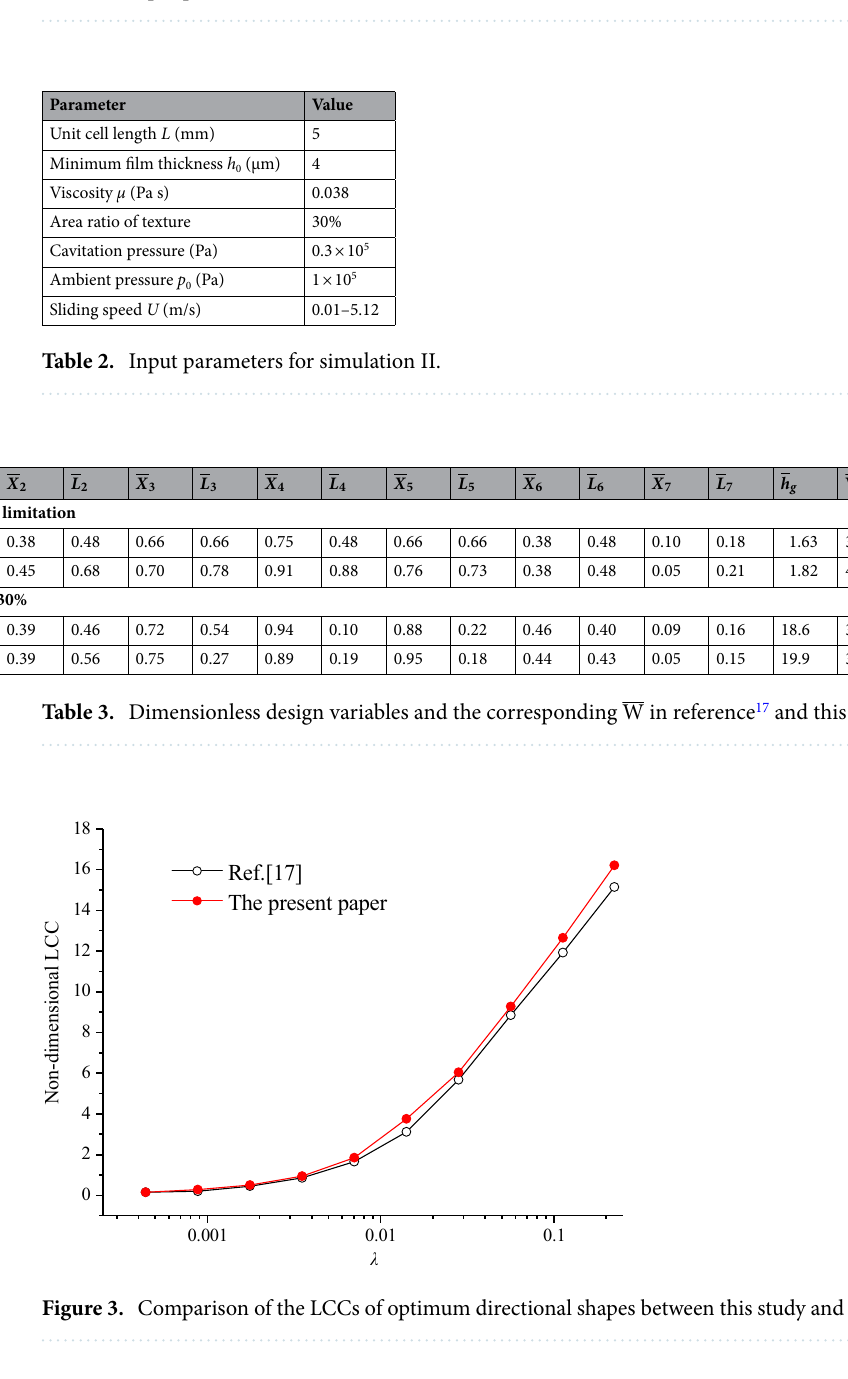
Table 1. Input parameters for simulation I.